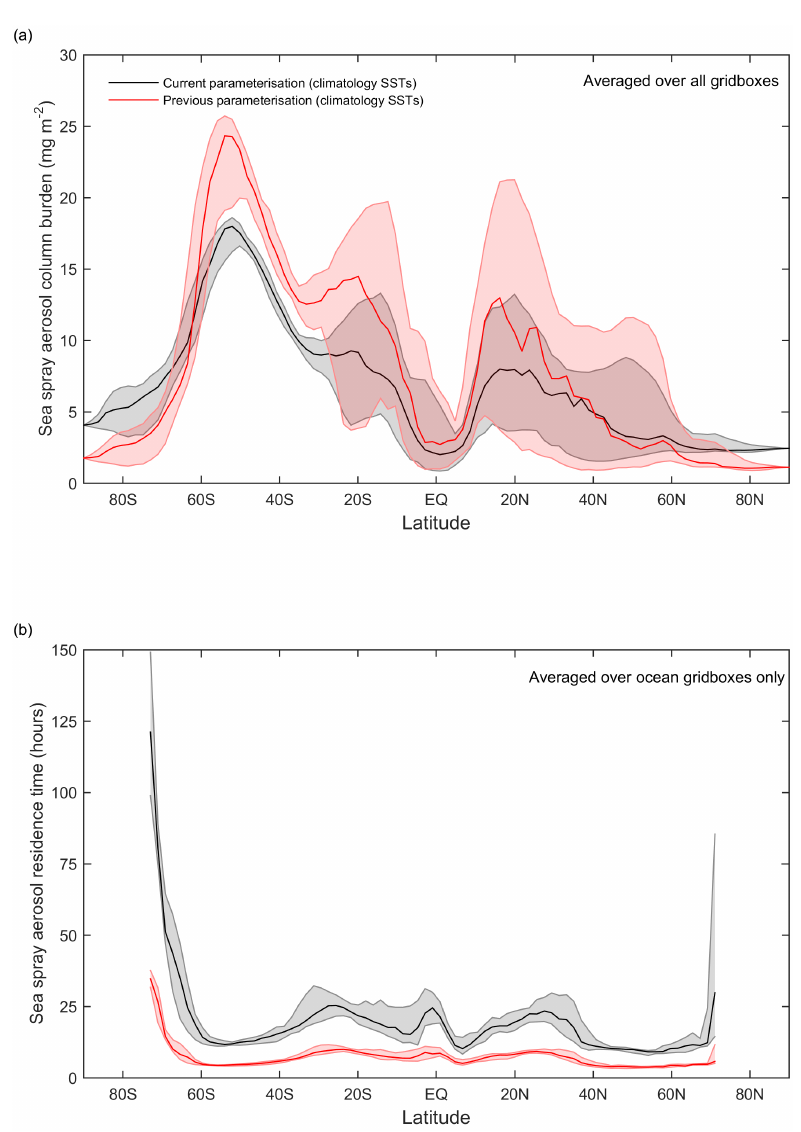
Figure 9. (a) Comparison of zonally (over all grid boxes) and annually averaged (median) sea spray aerosol column burden computed with the current parameterisation and the previous parameterisation (Kirkevåg et al., 2013). (b) Comparison of zonally (only ocean grid boxes) and annually averaged (median) sea spray aerosol residence time computed with the current parameterisation and the previous parameterisa- tion (Kirkevåg et al., 2013). Shaded areas represent the 25th and 75th